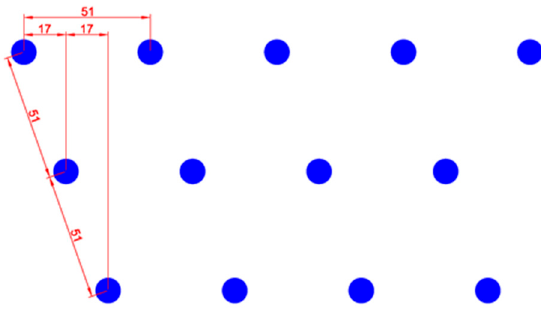
Figure 15. Wave farm layout.